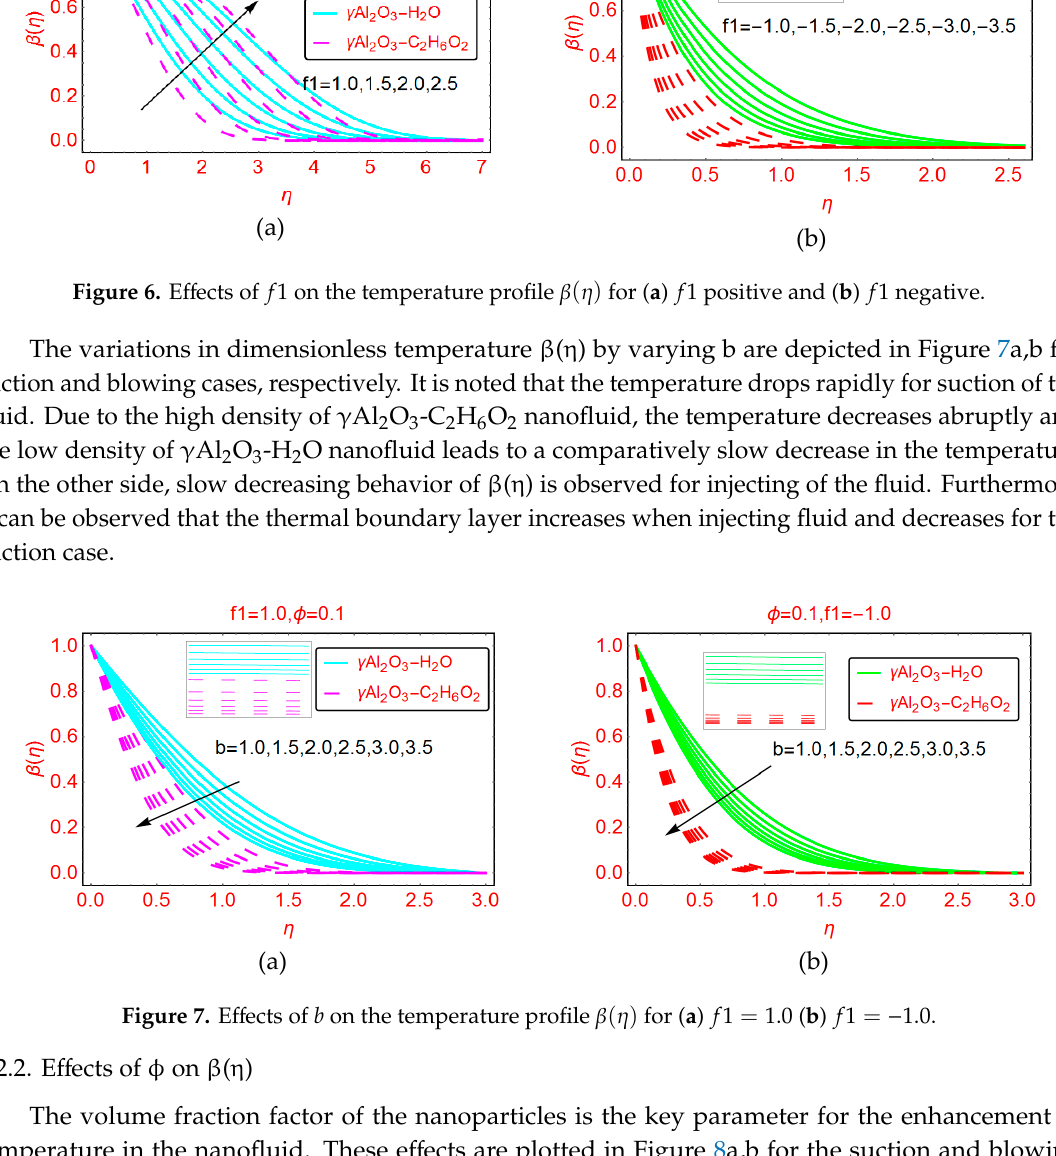
Figure 7. E ff ects of b on the temperature profile β ( η ) for ( a ) f 1 = 1.0 ( b ) f 1 = − Figure 7 . Effects of 𝑏 on the temperature profile 𝛽(𝜂) for ( a ) 𝑓1 = 1.0 ( b ) 𝑓1 = −1.0